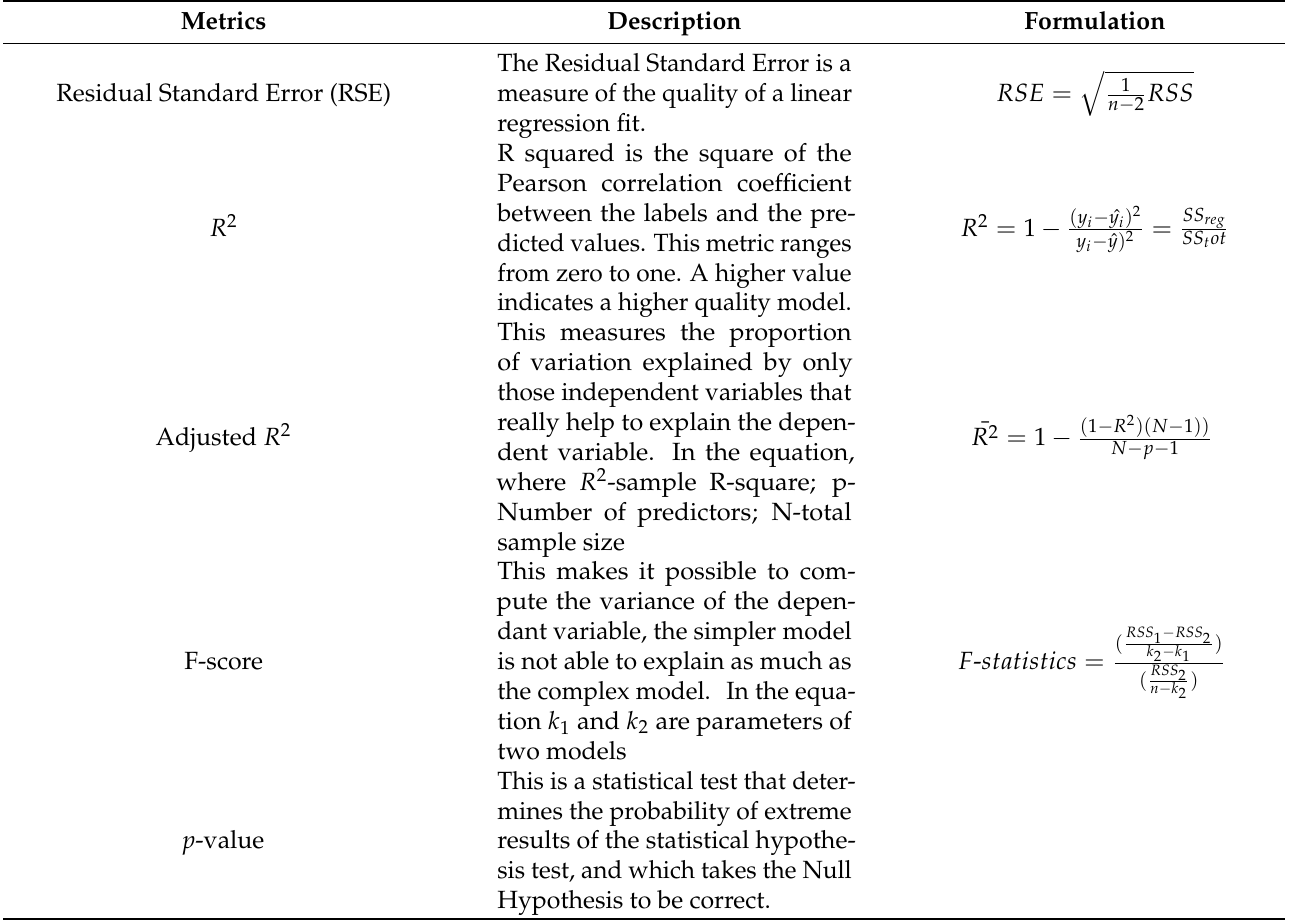
Table 2. Evaluation metrics of the linear regression model